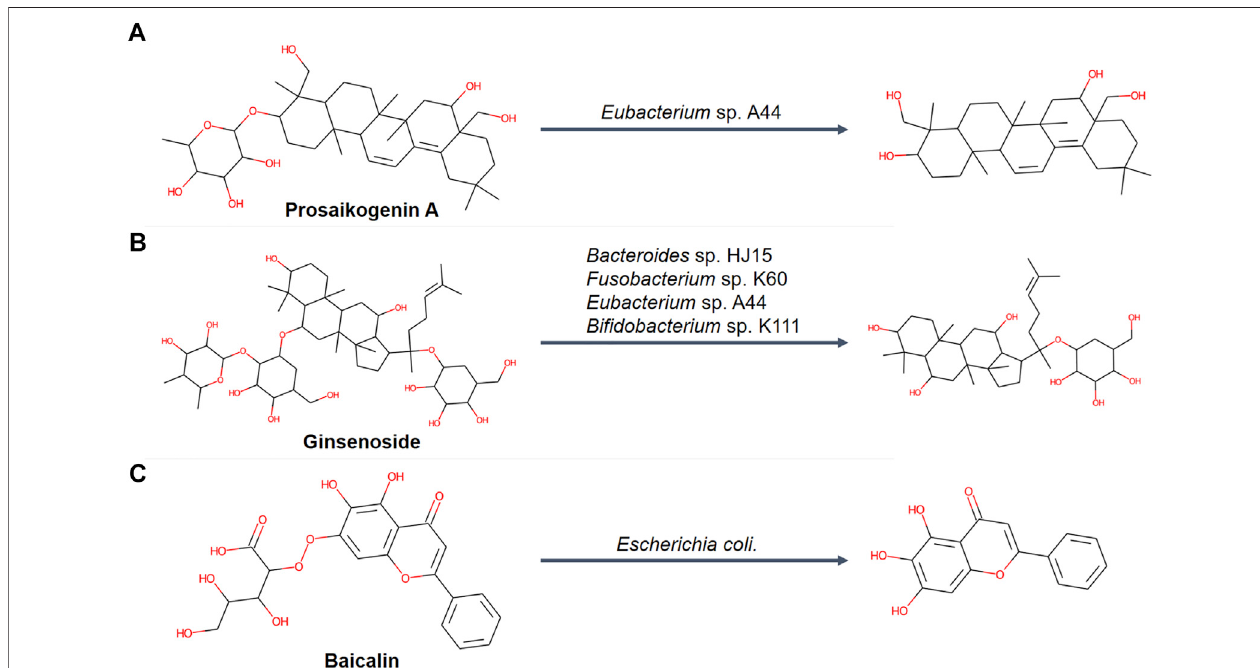
FIGURE3| Representativedeglycosylationprocessesmediatedbyintestinal fl orainanindependentdataset( n =14). (A) BiotransformationofprosaikogeninAthat was metabolized by Eubacterium sp. A44. (B) Biotransformation of ginsenoside that was metabolized by Bacteroides sp. HJ15, Fusobacterium sp. K60, Eubacterium sp. A44, and Bi fi dobacterium sp. K111. (C) Biotransformation of baicalin that was metabolized by Escherichia coli .